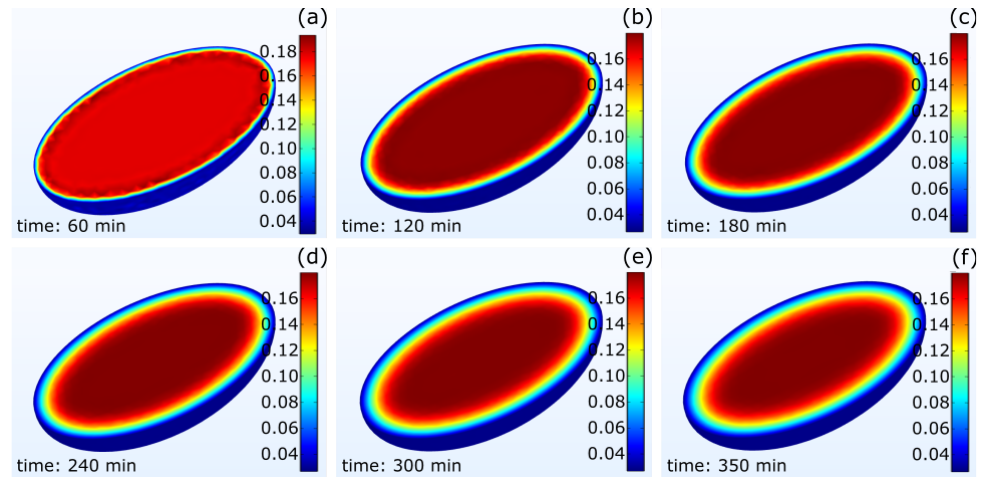
Figure 9. The time evolution of the dry basis moisture concentration (g H 2 O/g dry matter) inside the cocoa bean: ( a ) 60 min; ( b ) 120 min; ( c ) 180 min; ( d ) 240 min; ( e ) 300 min; and ( f ) 350 min after drying started.